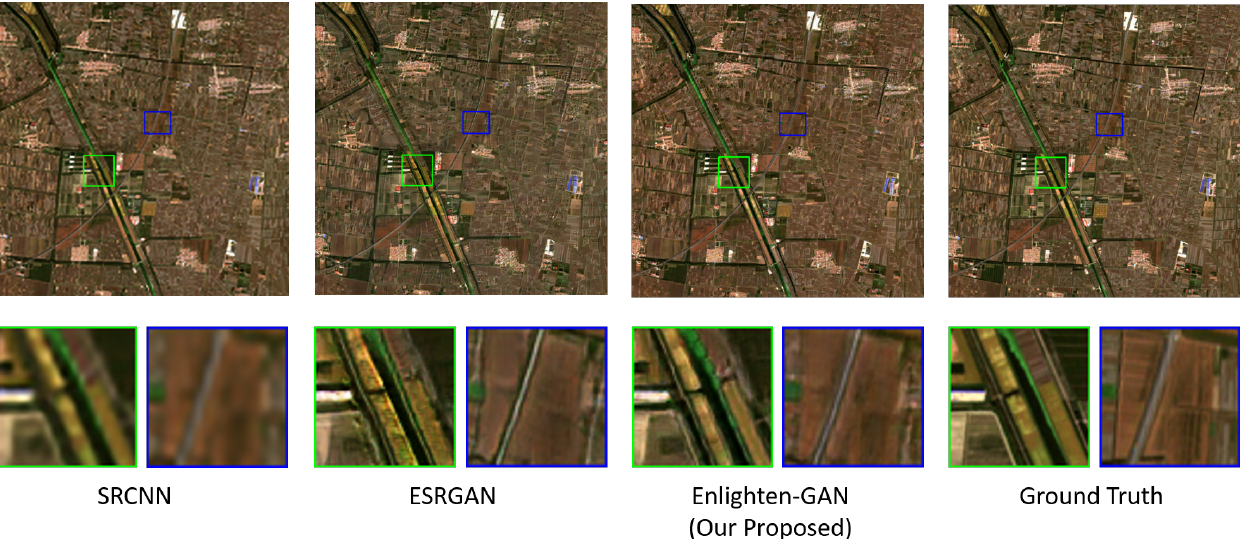
Figure 1. The super resolution reconstruction (SRR) results of SRCNN, ESRGAN, and our proposed Enlighten-GAN along with the ground truth. We crop and zoom the classic area, in relation to the observation of details. The result of SRCNN, as a representation for pixel-loss-based methods, is blurred for their conservative strategy, while the ESRGAN one is of the unpleasing artifacts. Our result is clear and reliable as a